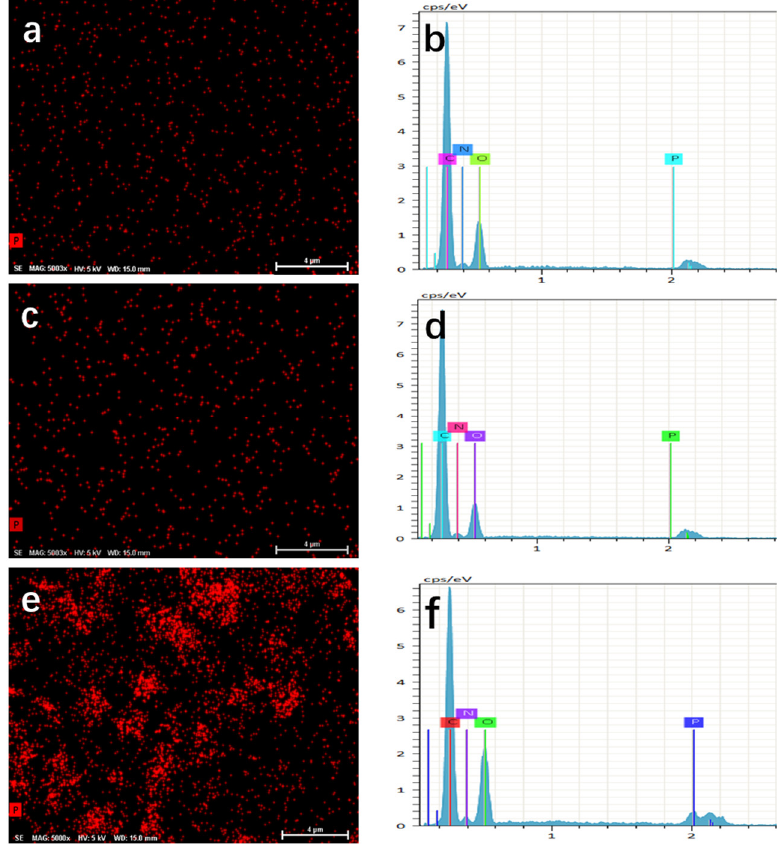
Figure 7. ( a ) phosphorus mapping of a region in pure WPU; ( b ) EDS test of the pure WPU; ( c ) phosphorus mapping of a region in pure BP/GWPU; ( d ) EDS test of the G/WPU; ( e ) phosphorus mapping of a region in G/WPU; ( f ) phosphorus mapping of a region in BP/G/WPU.